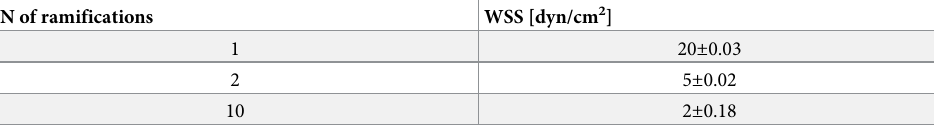
Wall shear stress within three different ramifications when a 30ml/min flow rate was